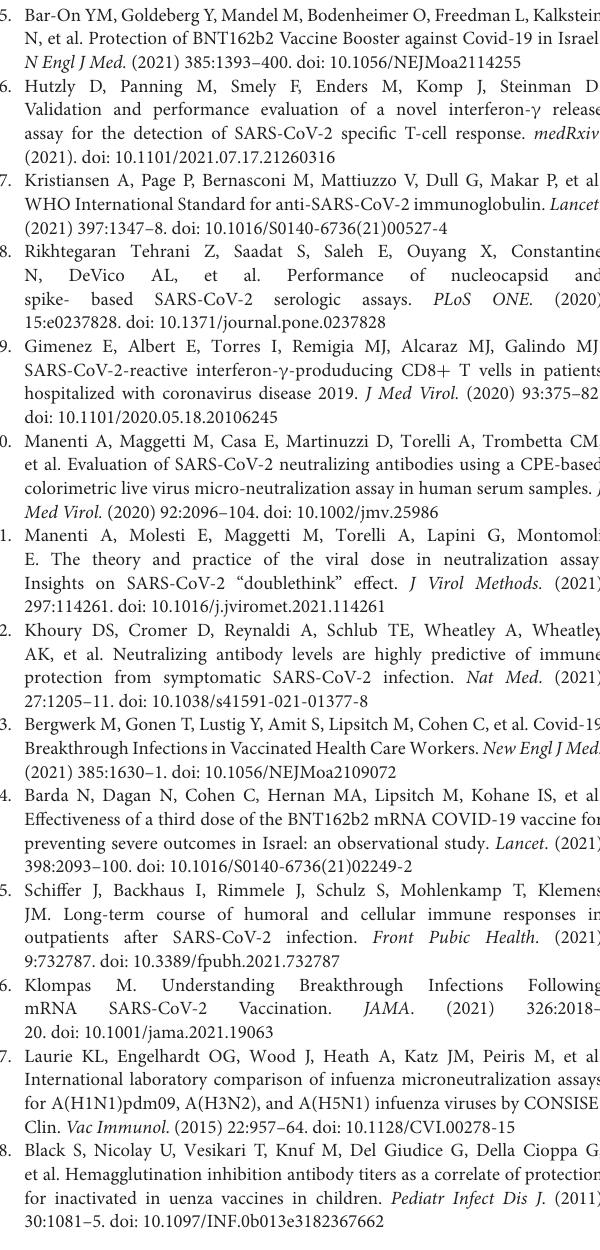
Supplementary Figure 1 | Day 60 Linear regression between IgG levels and IFN- γ concentration among COVID naïve group using the IFN- γ threshold of 100 mIU/ml. Supplementary Figure 2 | Day 60 Linear regression between IgG levels and IFN- γ concentration among COVID naive group using the IFN- γ threshold of 200